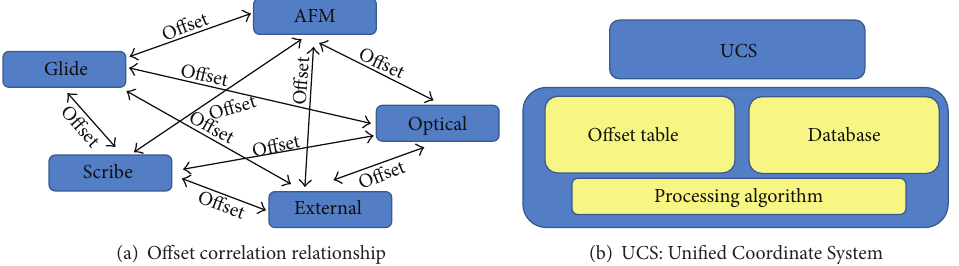
Figure 7: Schematic drawing showing the relationship and conversion among various coordinate systems. (a) Offset transformations that need to be handled if done individually. (b) Unified Coordinate System created to handle the transformation among the various coordinates with background algorithm and offset table. The parameters are stored in the database and undergo constant update when